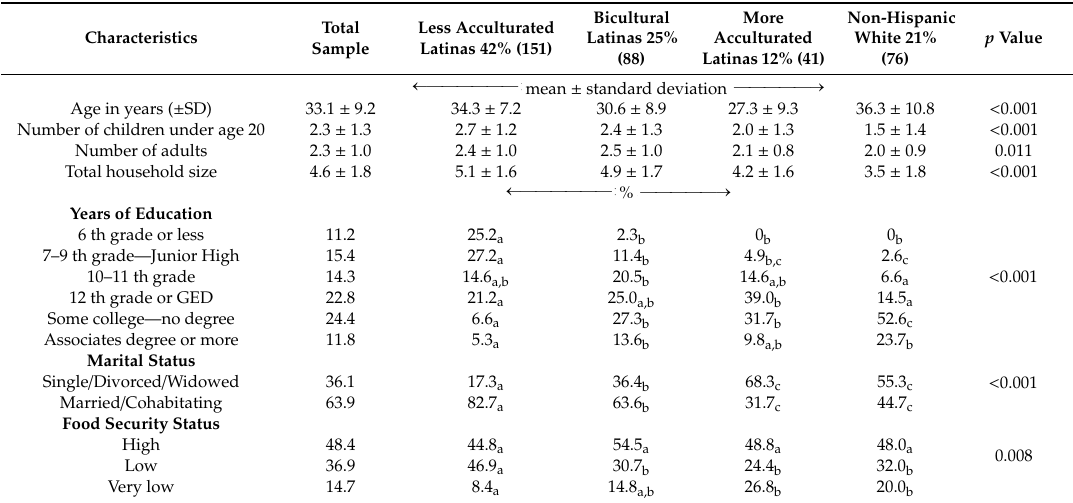
Table 1. Distribution of demographic and household characteristics of low-income Arizona women by Bidimensional Acculturation Scale classifications ( N = 356). Characteristics Age in years ( ± SD)